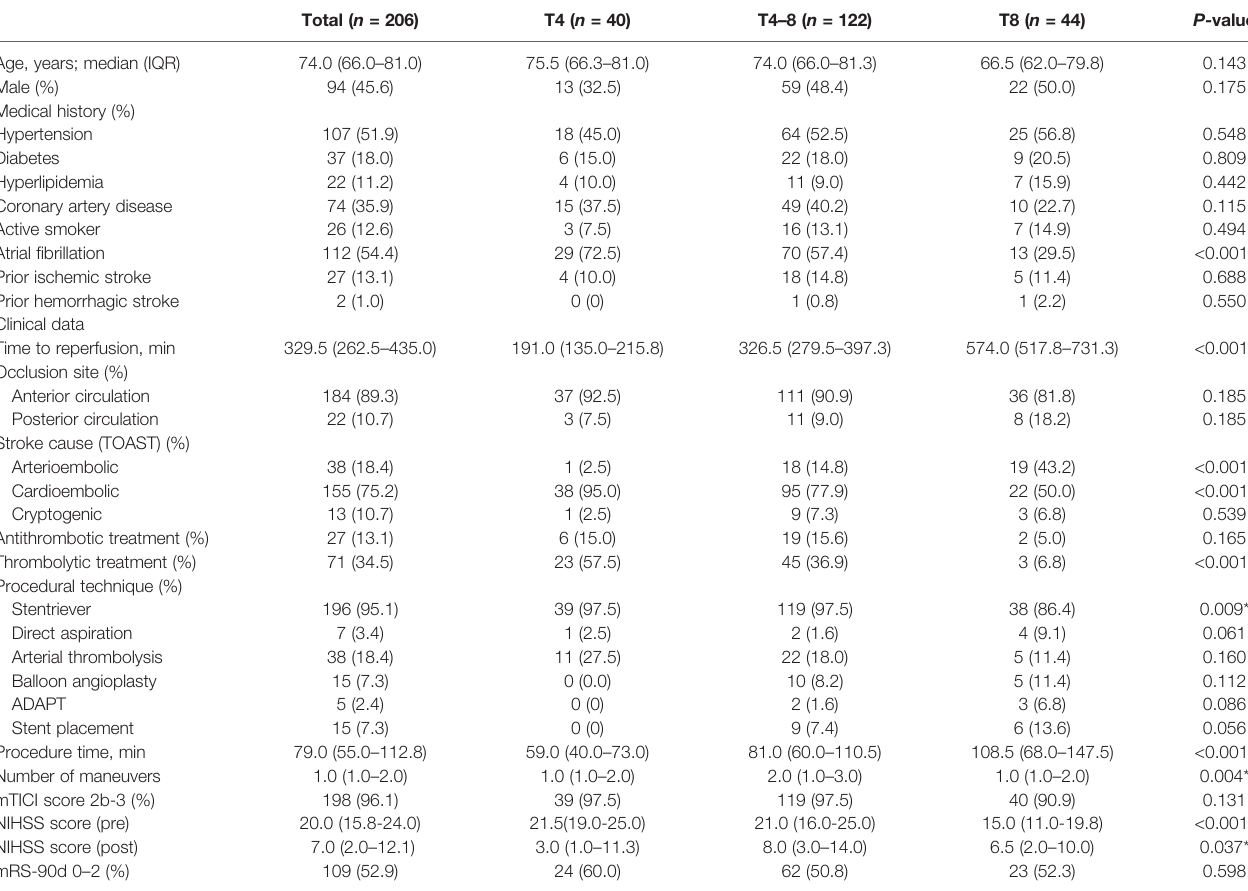
TABLE 1 | Characteristics of all